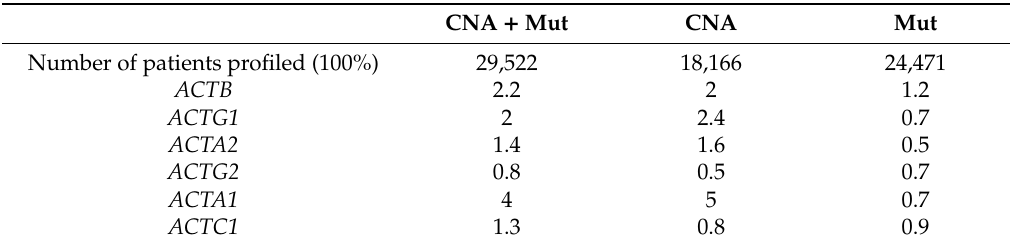
Table 1. Frequency (altered / profiled patients, in %) of alterations in actin genes in the 174 selected cancer studies (Table S1) in cBioPortal. CNA = copy number alterations, Mut = somatic mutations. Data derived from the Oncoprint tab.